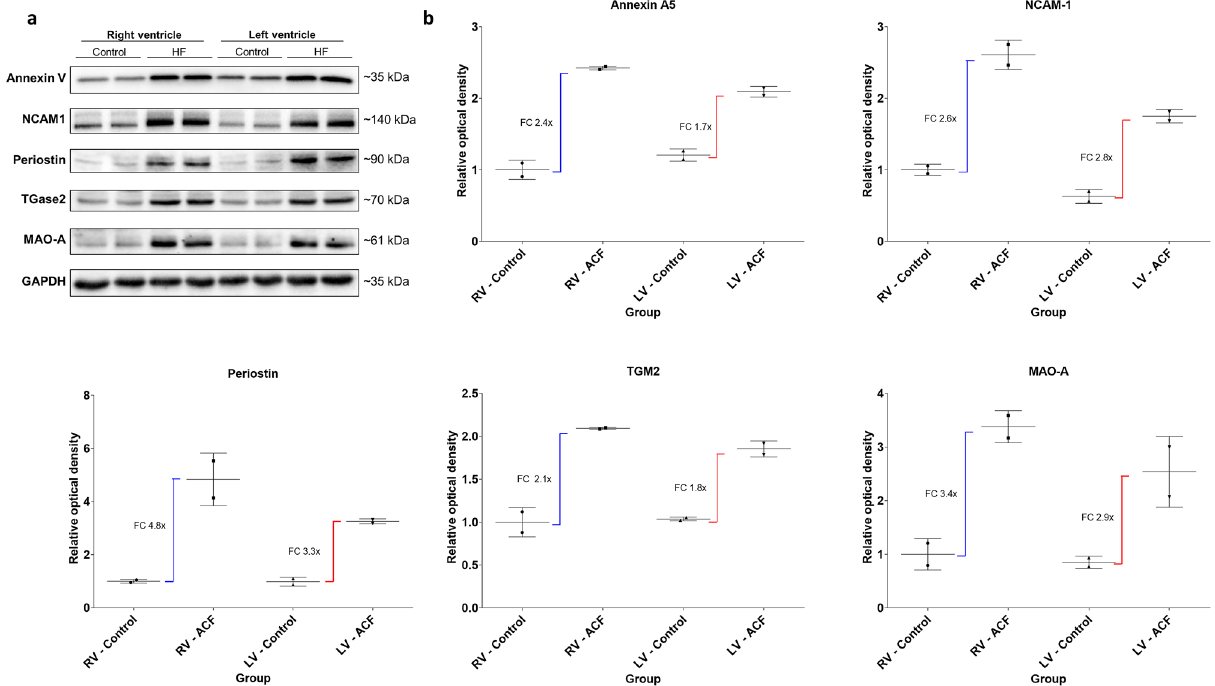
Figure 5. Confirmation of the differential expression of selected proteins using western blot analysis with specific antibodies and densitometry. ( a ) Western blot analysis using specific antibodies. Pooled myocardial samples (40 μg) were loaded and separated in duplicates. GAPDH was used as a loading control. NCAM-1 (Neural cell adhesion molecule 1), TGM2 (Tissue-type transglutaminase), MAO-A (Monoamine oxidase